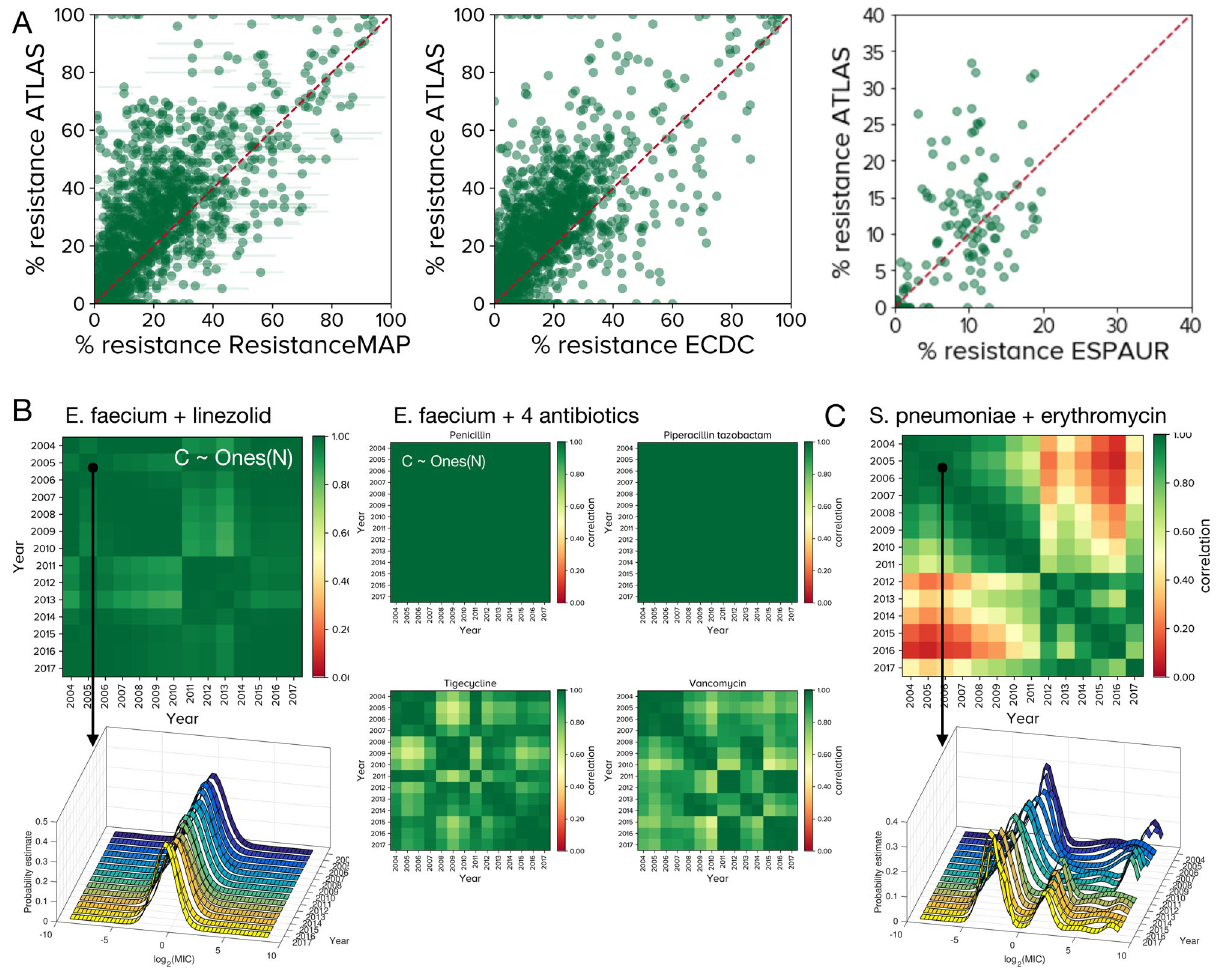
Fig. 1 Between database comparisons with ATLAS. A Each point represents a PA (pathogen-antibiotic) pair in a given country, for a given year with frequency of resistance ( f R as a %age) on x and y axes. ATLAS tends to over-estimates f R relative to ResistanceMap, ECDC and ESPAUR data: differences between f R in ATLAS and other databases are positively skewed, however between-database differences are smaller for larger PA pair datasets (Supplementary Fig. 2 has statistics). B Between-year correlations for many ATLAS PA pairs form correlelograms, called `C' here, that are close to the (pure green) unity matrix of ones, O nes(N), for N years. 5 PA pairs for Enterococcus faecium are shown. (Supplementary Fig. 8C has some correlelogram statistics, Supplementary Fig. 9 shows many are close to O nes(N) but not all, see Fig. 3 and Supplementary Fig. 10). The left column shows the global MIC (minimal inhibitory concentration) distribution of E. faecium and linezolid is stable from year to year and its correlelogram is close to O nes(N). The middle panel shows 4 correlelograms with banded structures that occur when MIC distributions experience change. C This correlelogram of Streptococcus pneumoniae and erythromycin have a block structure because their MIC distributions correlate poorly between years: a high-MIC cluster diminishes and is replaced by a cluster with lower MIC in 2010 – 2011 (c.f. Fig.